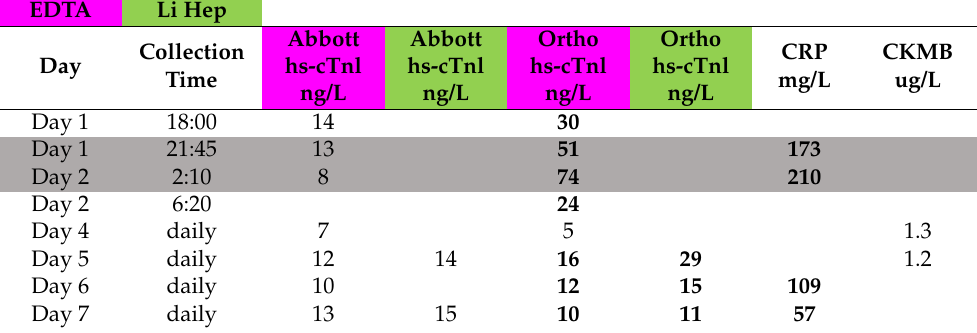
Table 1. Biochemical profile of the case where divergence between Ortho high-sensitivity cardiac troponin (hs-cTn)I and Abbott hs-cTnI levels are apparent with an increase in the acute phase re- sponse, as evident by the increase in C-reactive protein (CRP) concentrations (see grey highlighted rows spanning day 1 and day 2 of the patient’s admission). Bolded values are those that exceed the upper reference limits (URLs) of the respective assays with the purple heading representing ethylene- EDTA Li